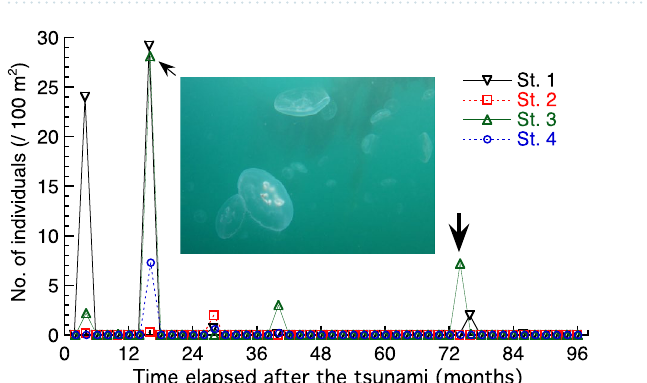
Figure 1. Sampling locations of sediment cores in northeast Japan. Double circle in (a) represents the earthquake epicenter. Adobe Illustrator CC (ver. 22.1, https:// www. adobe. com/ jp/ produ cts/ illus trator. html) was used to create the maps.